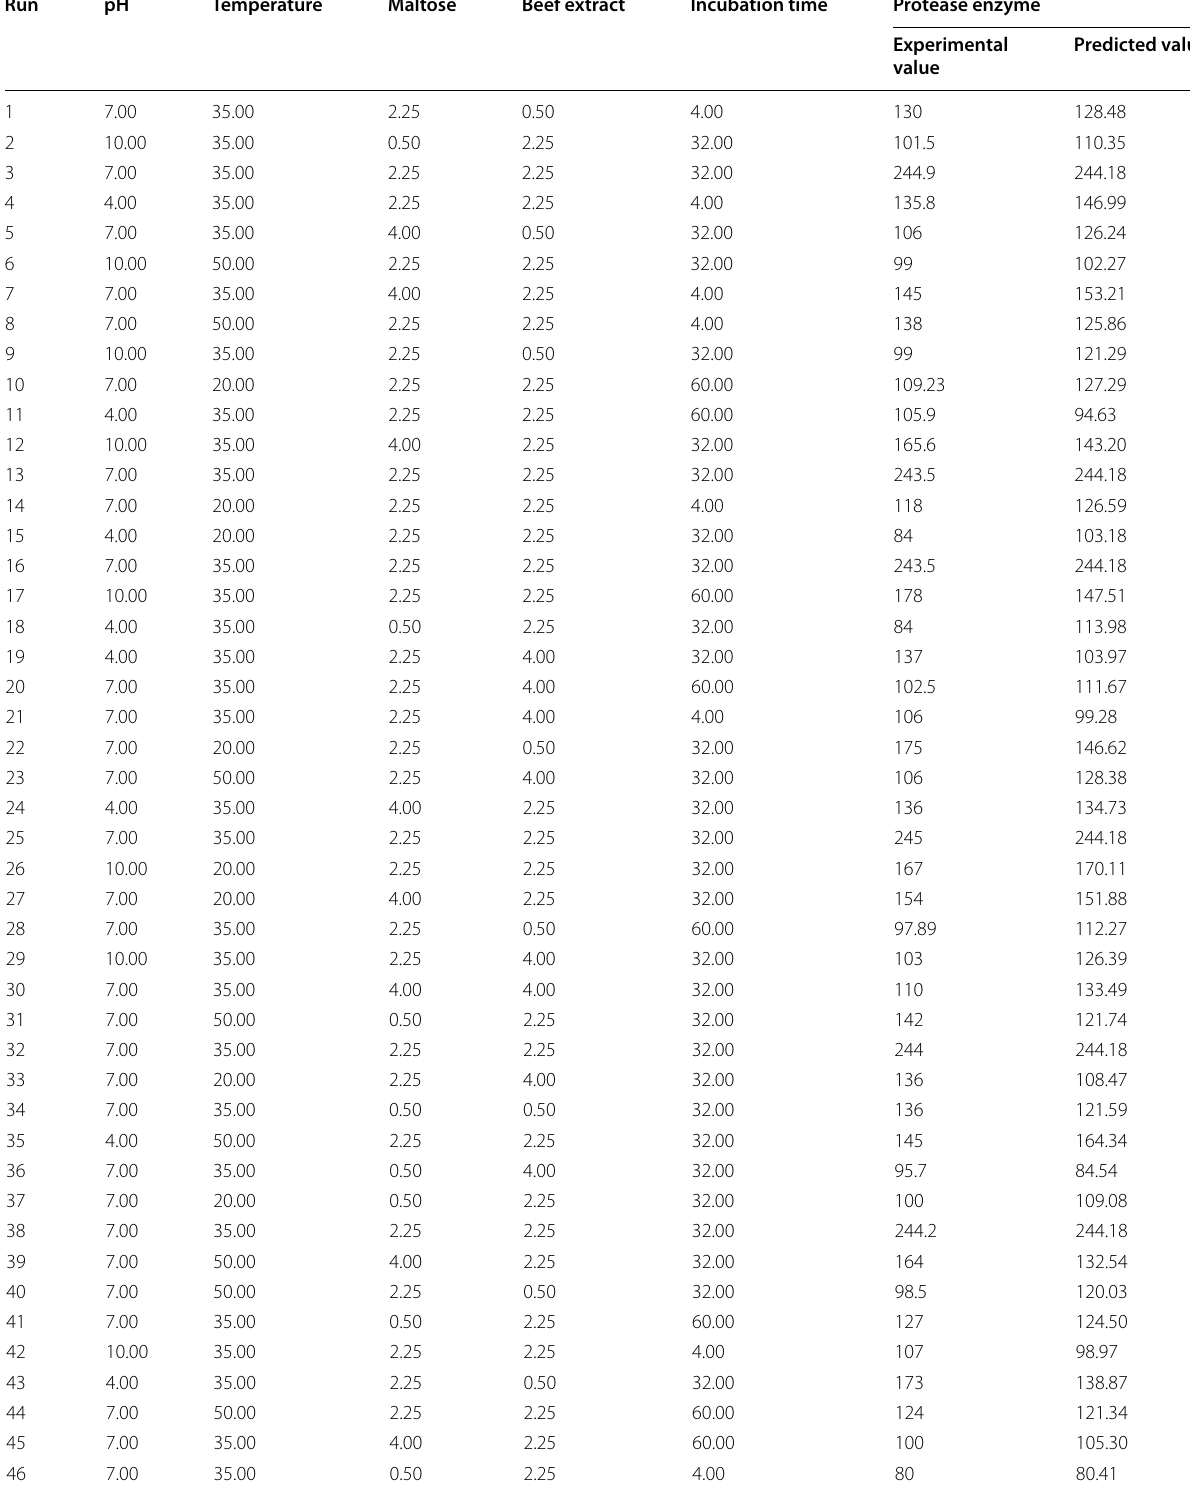
Table 3 Composition of various experiments of the PBD for independent variables and response Run pH Temperature Maltose Beef extract Incubation time Protease enzyme